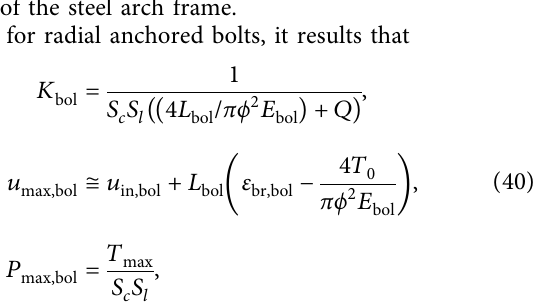
Table 1: Calculation parameters of surrounding rock.